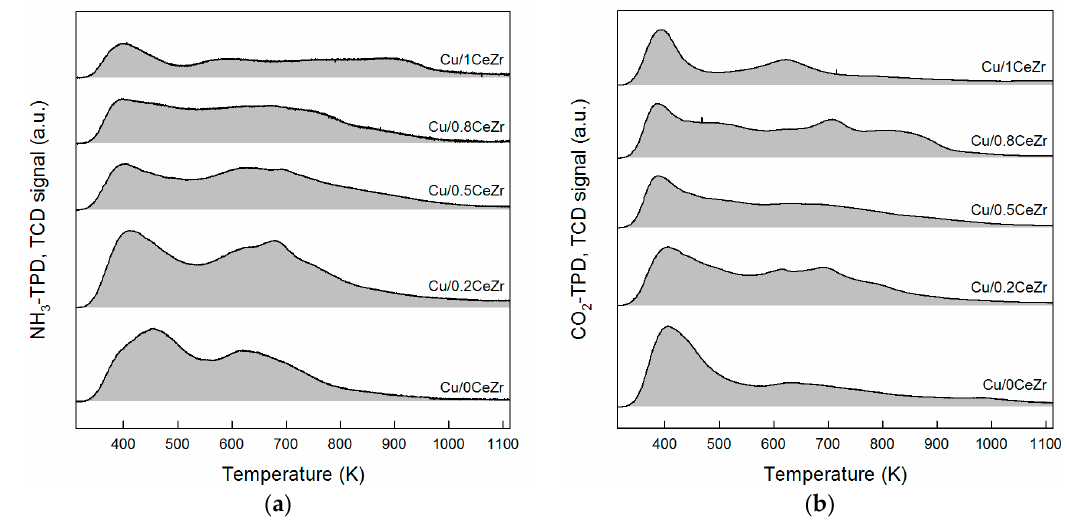
Figure 3. ( a ) NH 3 and ( b ) CO 2 temperature-programmed desorption profiles of Cu/ x CeZr